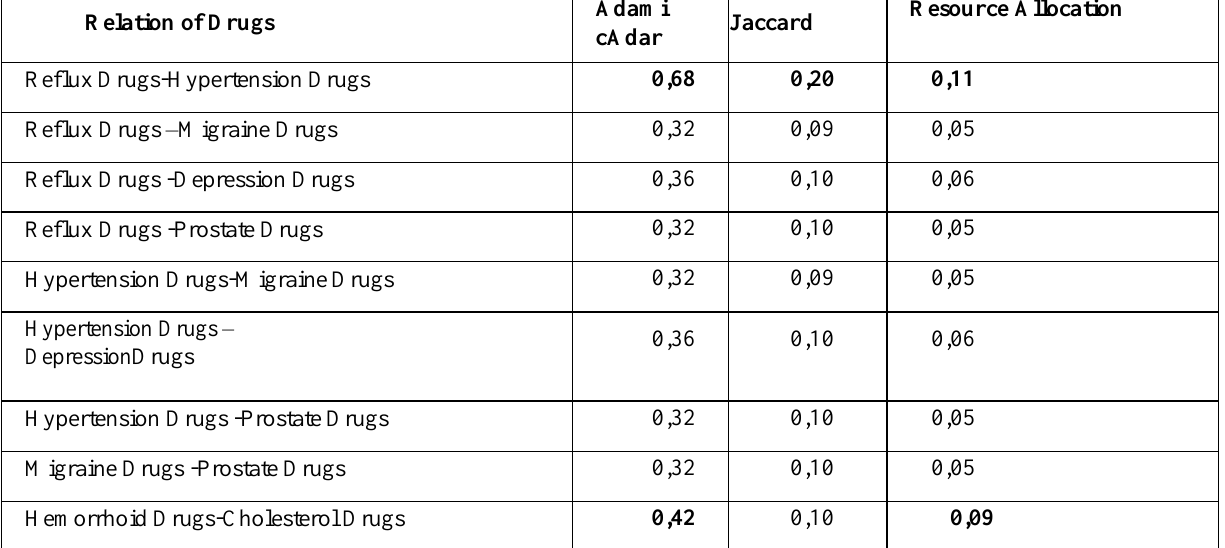
Table 4. The Estimated value of drugs